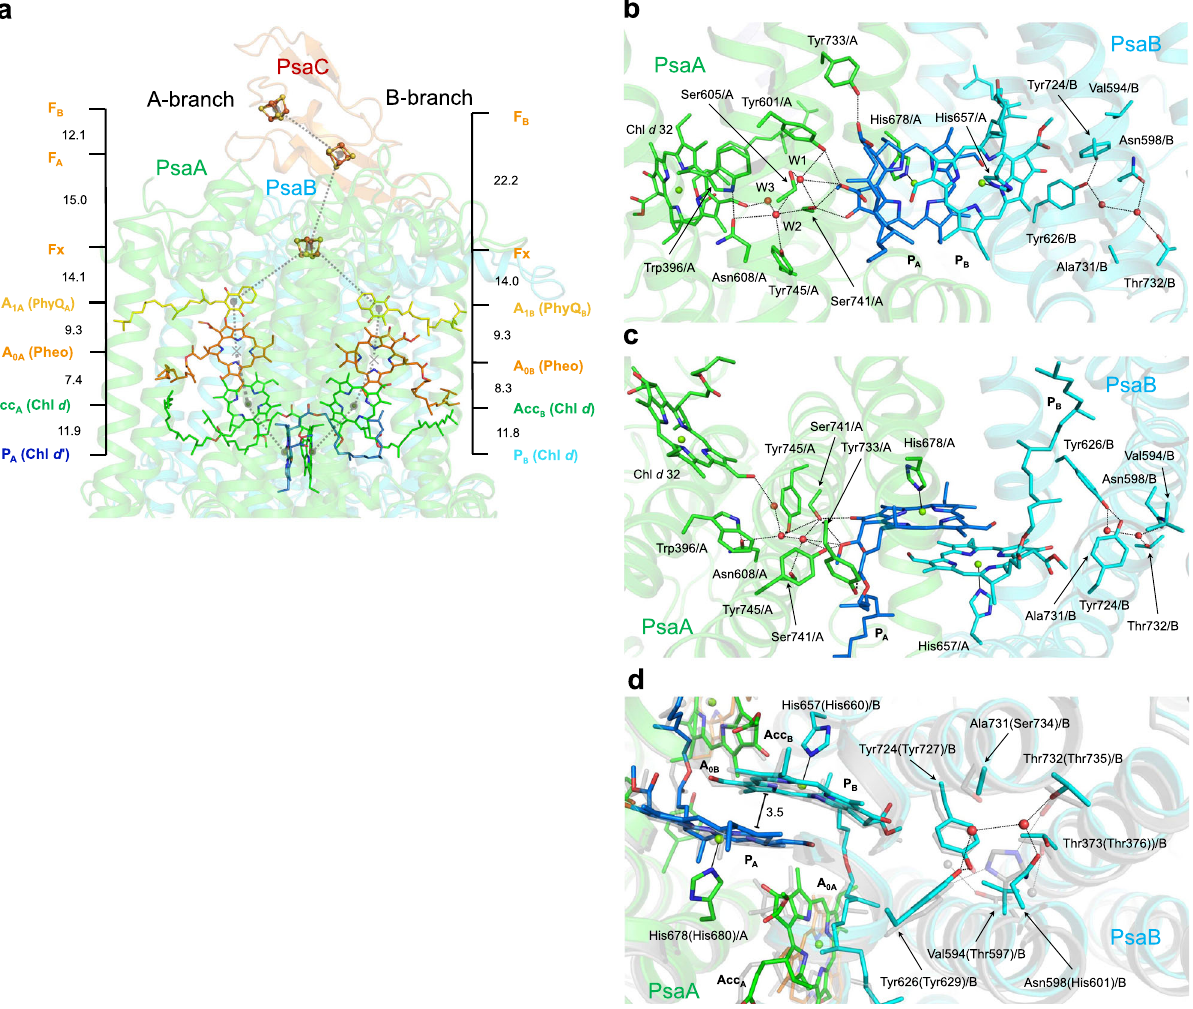
Fig. 3 Cofactors involved in the electron transfer reaction in A. marina PSI and their surrounding amino acid residues. a Arrangement of cofactors involved in the electron transfer reaction. Values on both sides represent the center – center distances (in Å ) between the cofactors. b Arrangement of P740 and its surrounding structure. View from the side of the membrane plane. c As in b , but view from the pseudo-C 2 axis. d Arrangement of the amino acid residues in fl uencing E m (P A ) and E m (P B ). Superposition of the structural model of PSI from A. marina with that from T. elongatus (PDB code 1JB0). Transparent green and blue, PSI from A. marina ; transparent gray, PSI from T. elongatus . Chlorophyll (Chl) d , green; Chl d ′ , blue; water molecule,